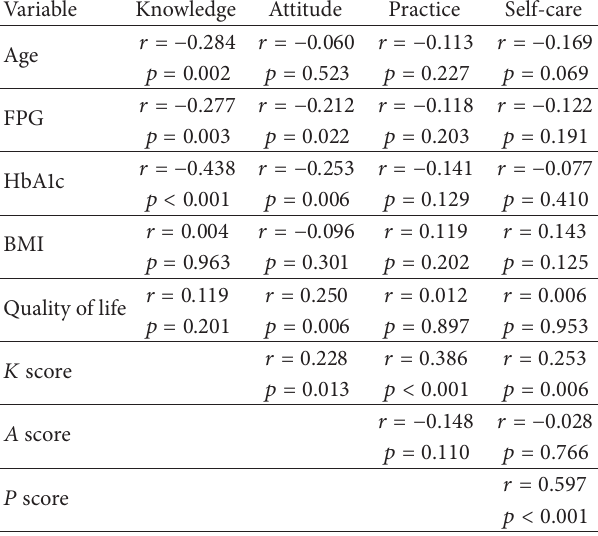
Table 3: Correlation of patients’ knowledge, attitude, practice, and self-care with confounders.